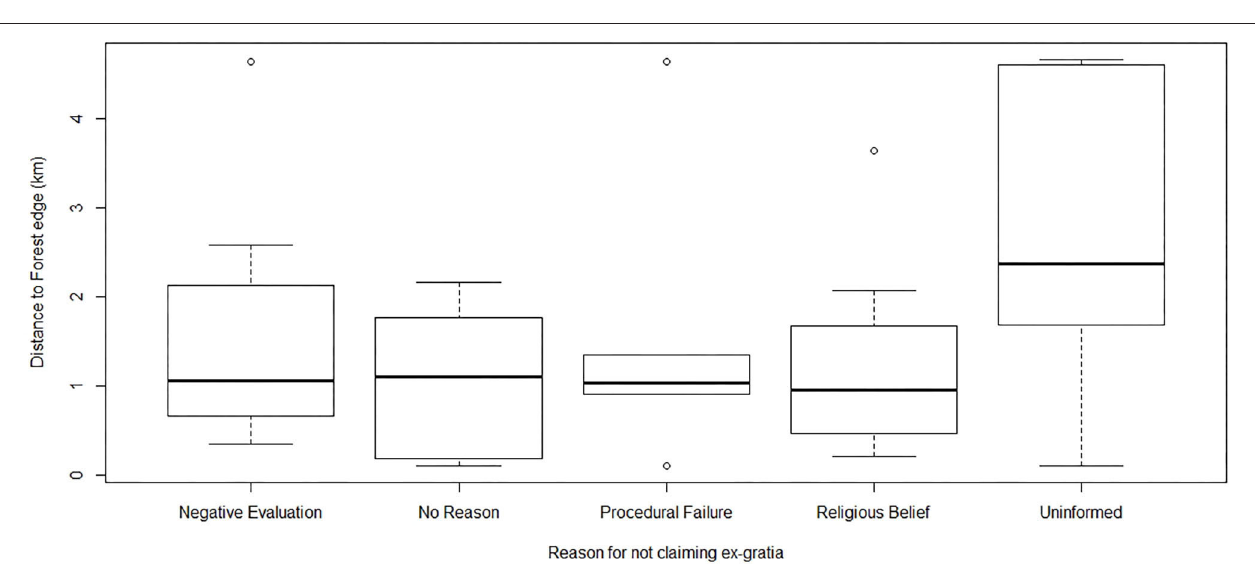
FIGURE 4 | The box-plot showing the effect of distance to forest on reasons for not-claiming relief, distance is in